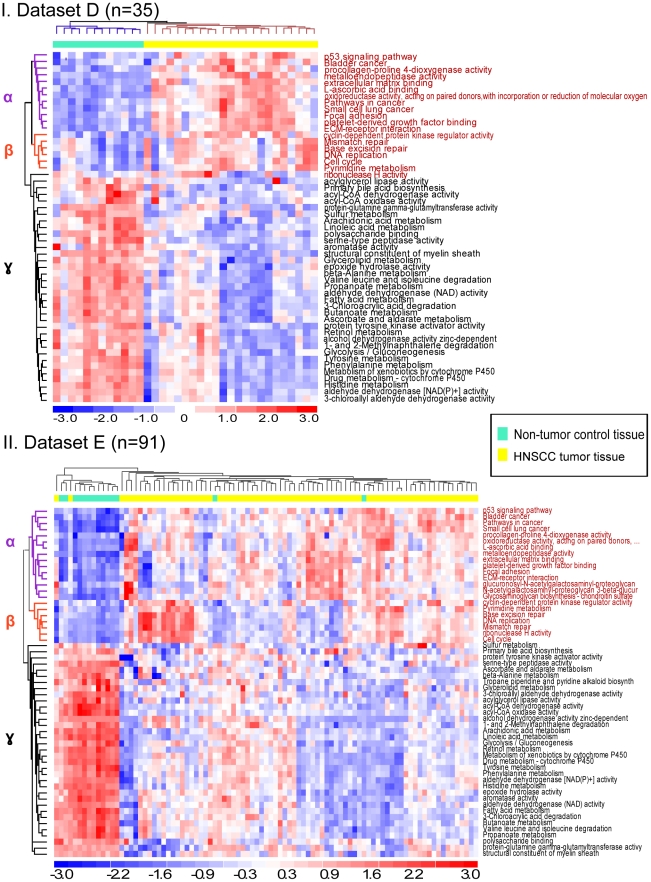
Significantly altered FAIME-derived Oncogenic FAIME Features of HNSCC accurately classify samples of two independent validation datasets.In Figure 3, we reported 57 FAIME-derived mechanisms, collectively referred to as the Oncogenic FAIME Features of HNSCC, that were reproduced in each of the independent HNSCC datasets. These consist of 33 KEGG pathways and 24 GO molecular function terms that were significantly deregulated between HNSCC tumor samples and non-tumor control tissue in all three HNSCC datasets at an FDR<5% (A, B and C, Table 1). Here, we demonstrate that the FAIME Scores calculated at the individual sample level in each of the independent validation datasets for these mechanisms can serve as a “functional” profile rather than a gene profile in sample clustering, a distinctive novel property of FAIME. Panels I and II respectively show unsupervised average-linkage hierarchical clustering analysis of the Euclidian distances of FAIME Scores for each sample from the two independent validation datasets, D and E, described in Table 1. As hypothesized, cancer tissue samples are significantly discriminated from non-tumor control tissue ones in both datasets (Panel I: FAIME-Score = 100%, no misclassification, 100 runs of 5-fold cross-validation: AUC = 0.99, p = 4.3×10−7; Panel II: FAIME-Score = 97%, 4 misclassifications among 91 samples, 100 runs of 5-fold cross-validation: AUC = 0.92, p = 1.8×10−12). Additional conservative empirical p<0.001 are obtained in both panels by permutation resampling of features in AUC calculation. Pathways and molecular functions in sub-clusters α and β (seen on the left of Panels I, II) are also found similarly clustered in both independent evaluations.